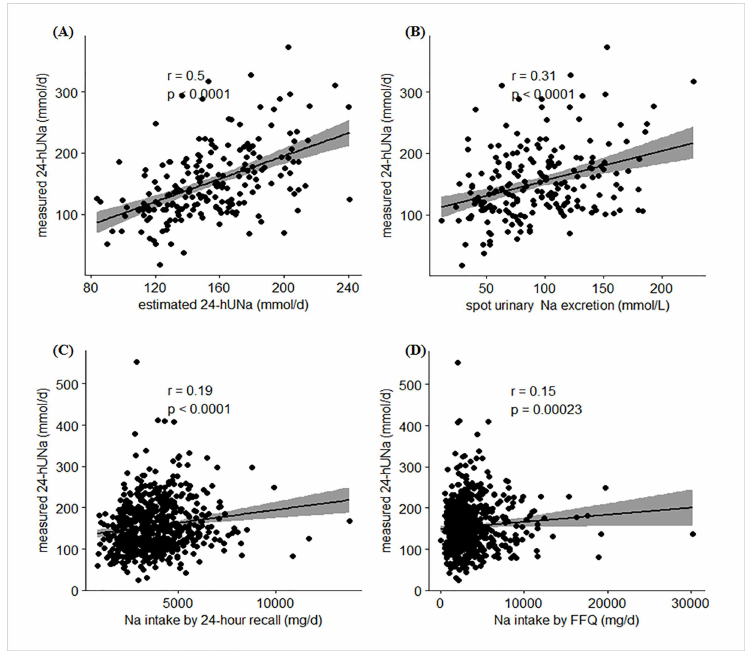
Fig 1. Correlation a between measured 24-hUNa b and other sodium-related variables (training set, study 1 & validation set, study 2) 24-hUNa, 24-h urinary-sodium excretion. a Spearman’s correlation coefficient between measured 24-hUNa and other sodium-related variables.b Measured 24-hUNa using 24-h urine (mmol/d). Panel (A): Estimated 24-hUNa (mmol/d), validation set; Panel (B): Spot urinary Na excretion (mmol/L), validation set; Panel (C): Na intake by 24-h recall (mg/d), training set; Panel (D): Na intake by FFQ (mg/d), training set.